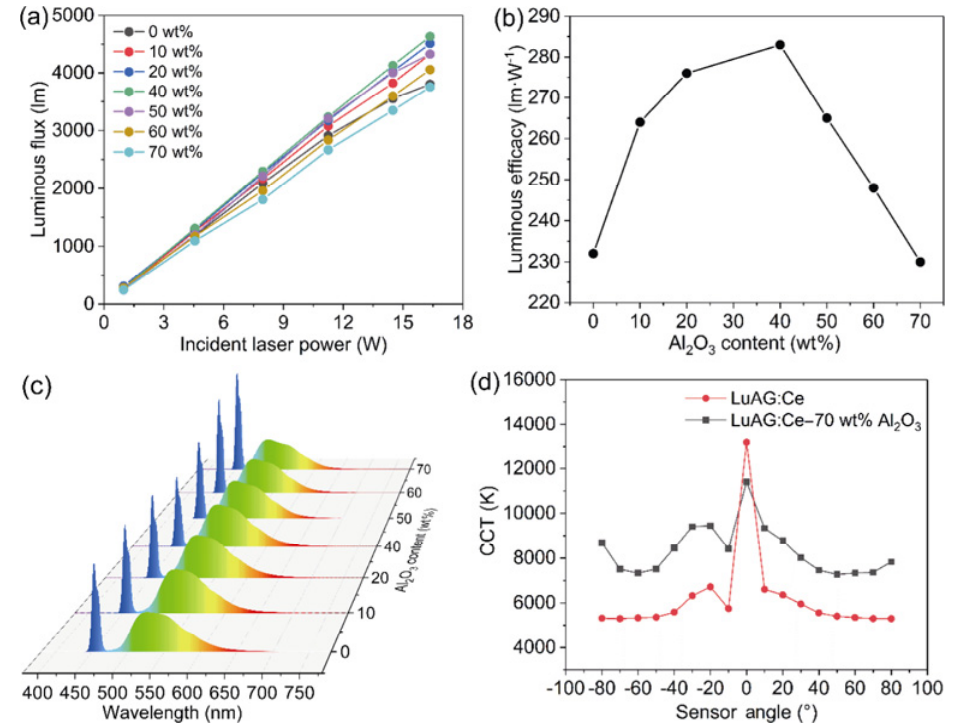
Fig. 6 (a) Luminous flux of LACCs as a function of incident blue laser. (b) Luminous efficacy and (c) EL spectra of LACCs under 16.4 W blue laser excitation. (d) Color temperature distribution of LuAG:Ce and 70 wt%